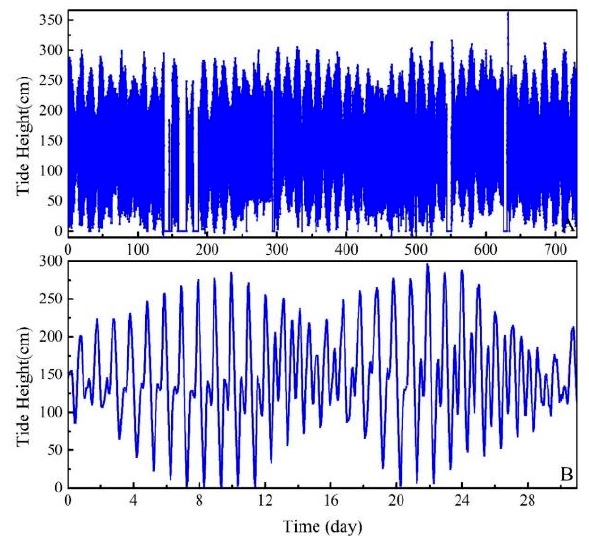
Figure 4. The long term and high frequency tide heights in 2007 and 2008 ( A ) and the tide heights throughout January 2008 ( B ) at Tsim Bei Tsui in Deep Bay.